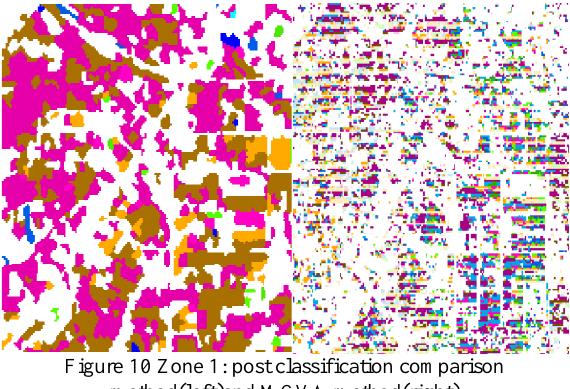
Figure 10 Zone 1: post classification comparison method(left)and MCVA